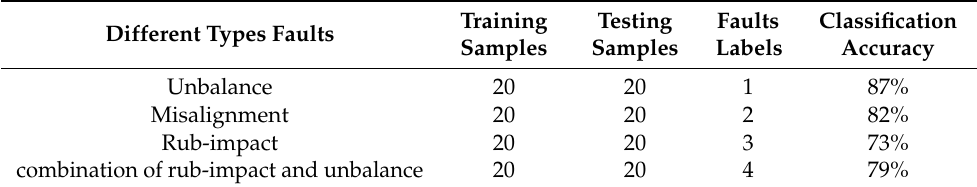
Table 6. The different types of faults’ recognition